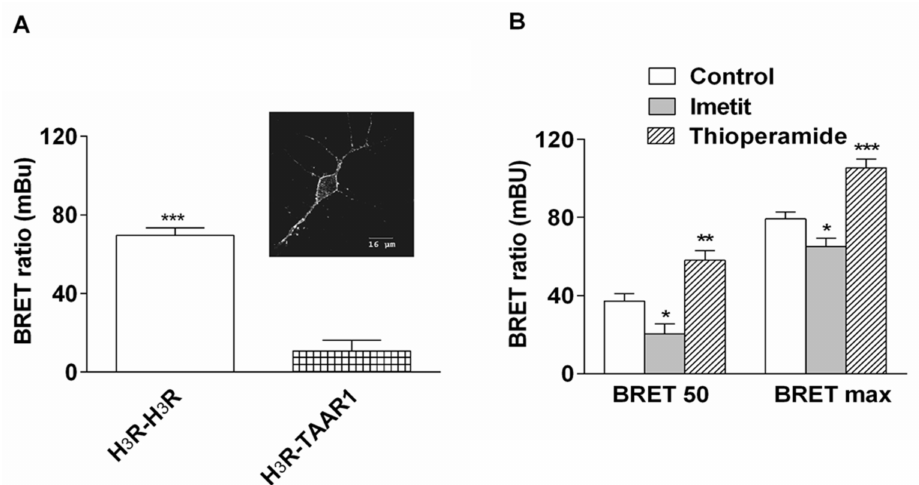
Figure 5. Effects of H 3 -receptor ligands on BRET signals in cultured cortical neurons. ( A ) Sub- cellular localization of H 3 R-YFP in rat cortical neurons, as observed by confocal microscopy two days after transfection. ( A ) Cortical neurons were transfected with H 3 R-RLuc and H 3 R-YFP or TAAR1-YFP as a control receptor in order to obtain sub-maximal BRET signals. A similar level of H 3 R-YFP and TAAR1-YFP expression was ensured by fluorescence analysis. Data are the means of 6 values from two independent experiments. *** p < 0.001 versus H 3 R-TAAR1 heterodimers. ( B ) Effects of ligands (100 nM) on H 3 R dimerization were evaluated at two different BRET levels. Means ± SEM of 18–24 values from 3–4 separate experiments. Two way ANOVA was performed as follows: factor BRET F(1, 99) = 152.2, p < 0.001; factor treatment F(2, 99) = 34.8, p < 0.001; and interaction F(2, 99) = 0.196, p = 0.8. Then, the effect of ligands was evaluated in each BRET group using a non-parametric Wilcoxon/Mann–Whitney test, * p < 0.05, ** p <0.01, *** p < 0.001 versus respective